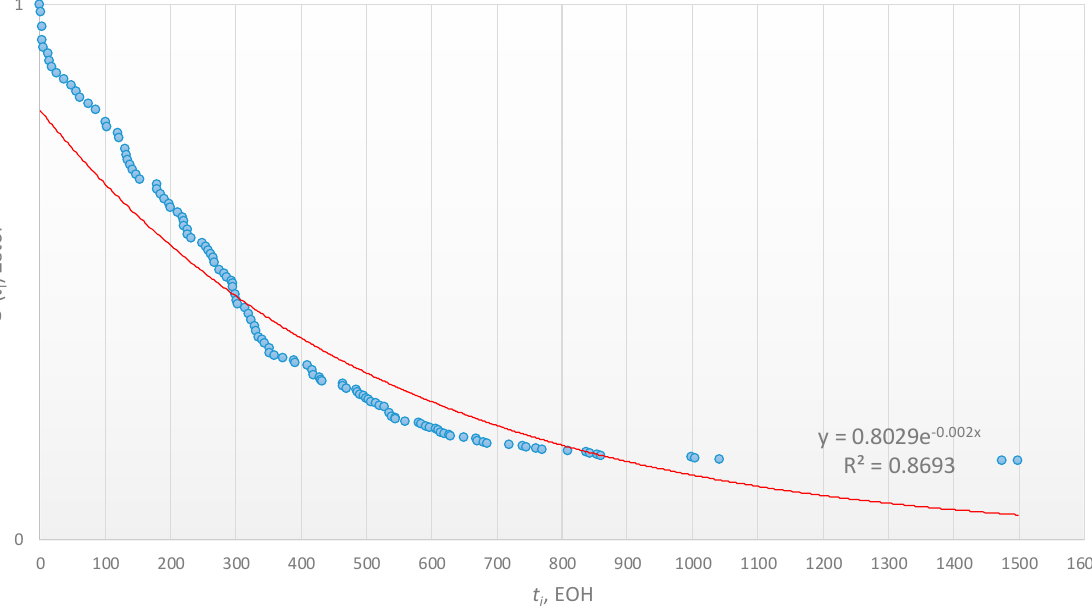
Figure 3. The K–M survival function for Zetor brand farm tractors and the regression function. Own calculations made in an Excel spreadsheet.